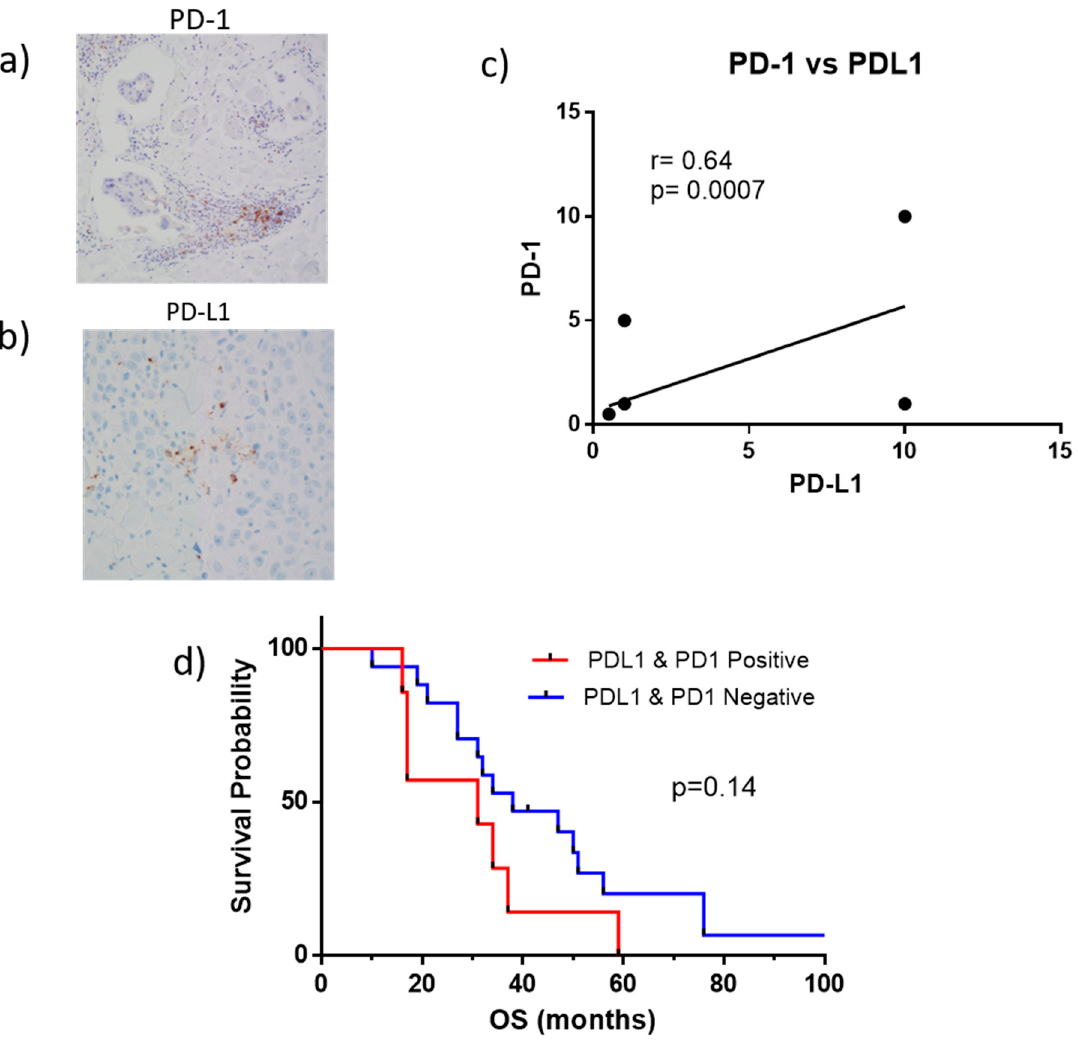
Figure 4. PD-1 and PD-L1 expression in IBC tumor biopsies. ( a ) Representative IHC staining of PD-1 (200 × magnification); ( b ) representative staining for PD-L1 (200 × magnification); ( c ) correlation between PD-1 and PD-L1 using a Spearman test; ( d ) Kaplan–Meier survival curves for IBC patients with PD-L1 and PD-1 positive (Median OS = 31 months) and PD-L1 and PD-1 negative tumors (median OS = 38 months).